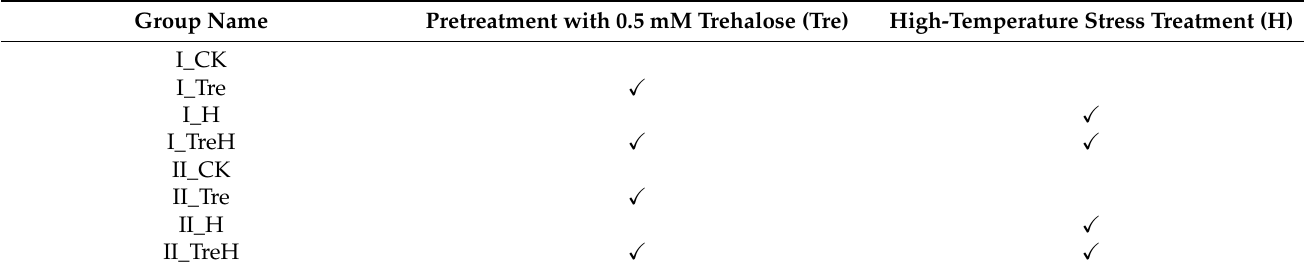
Table 3. Treatment of each experimental group of